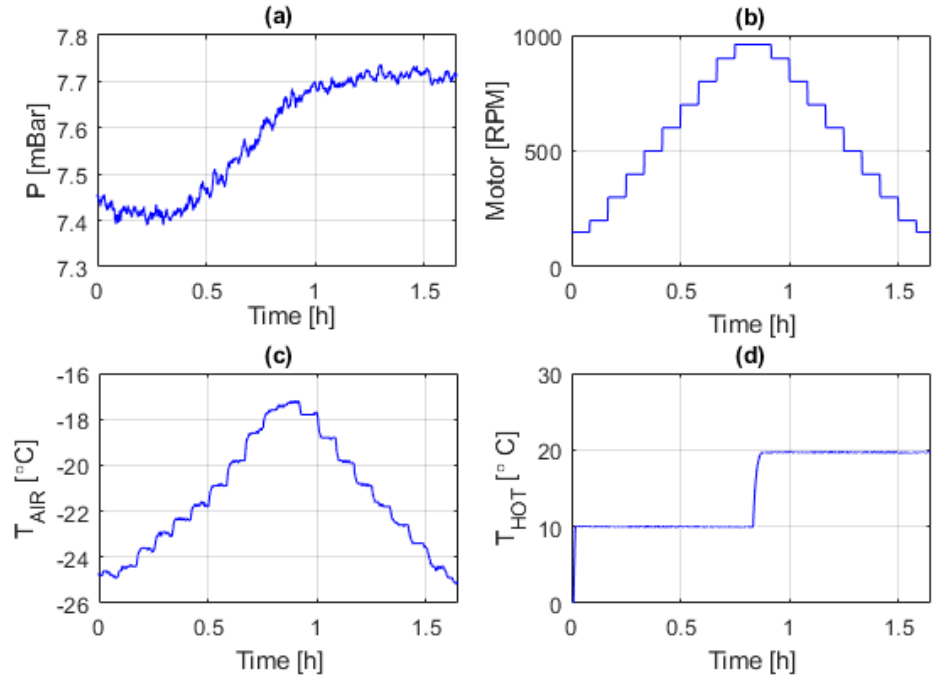
Figure 6. Time evolution, during the first experiment, of: ( a ) The pressure in the wind tunnel; ( b ) rotation speed of the fan in the wind tunnel; ( c ) temperature of the air; ( d ) temperature in the sphere sectors. The wind velocities tested were: 1.5, 2, 3.6, 5.6, 7, 9, 10, 12, 14, 16 m/s.